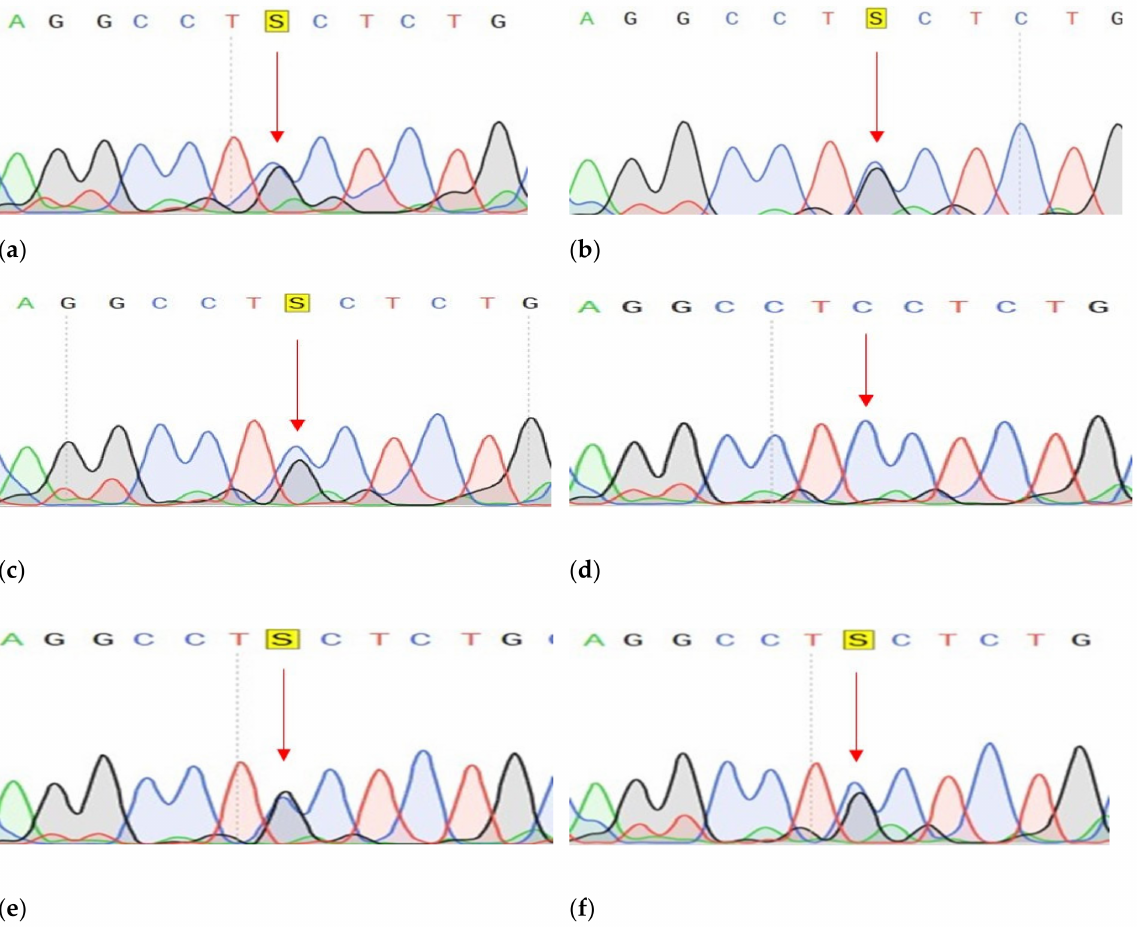
Figure 9. Fragments of the DNA sequence locus in the FANCA gene (DNA sample with difference in melting point): ( a – d ) Patients with GC; ( e , f ) healthy